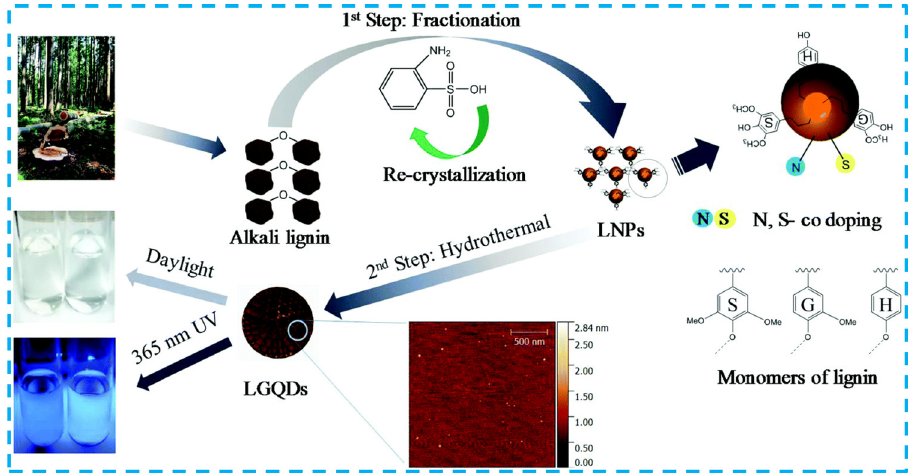
Figure 15: Schematic for the green bottom - up synthesis of lignin - based GQDs via a two - step method. Copied with permission from ref. [ 178 ] ; Royal Society of Chemistry,